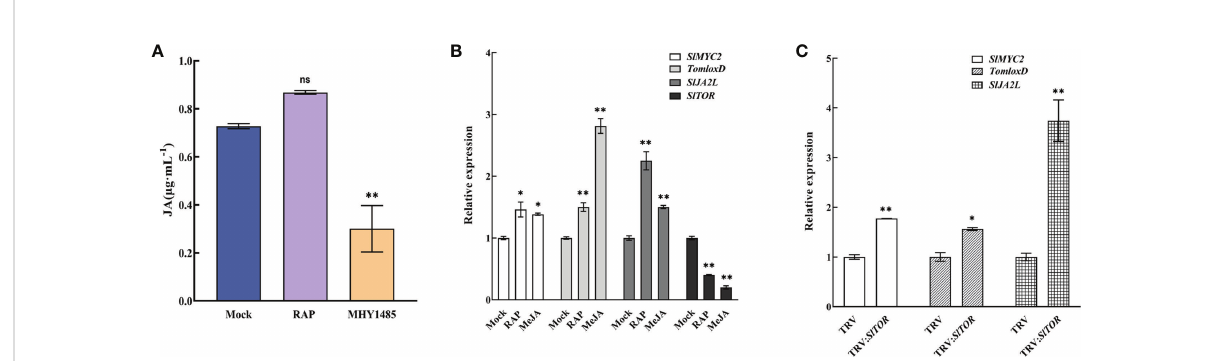
FIGURE 6 Crosstalk between JA signaling and TOR signaling pathways. (A) Endogenous JA content in tomato leaves after treatment with RAP and MHY1485. Mock, Control group. RAP, RAP treatment. MHY1485, MHY1485 treatment. (B) Expression of SlMYC2 , TomloxD , SlJA2L and SlTOR after RAP and MeJA treatment. Mock, Control group. RAP, RAP treatment. MeJA, MeJA treatment. (C) Expression of SlMYC2 , TomloxD and SlJA2L in TRV : SlTOR . TRV, only in fi ltrated with empty vectors. TRV : SlTOR , SlTOR -silenced lines. Errors are standard deviations for three biological replicates (n=3). Differences between means were analyzed for signi fi cance using Student ’ s t test, *P < 0.05, **P < 0.01. ns, no signi fi cant